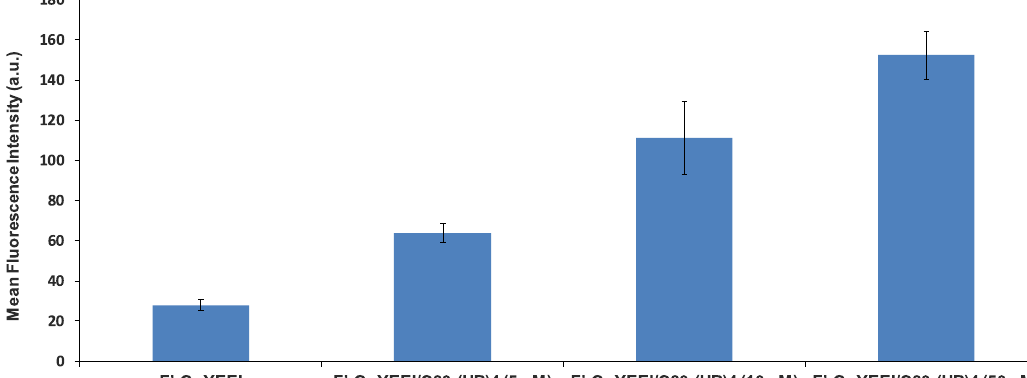
Figure 5. Cellular uptake study of F’-GpYEEI (5 µM) by fatty acyl-(HR) 4 derivatives at 50 µM in SK-OV-3 cancer cell lines.